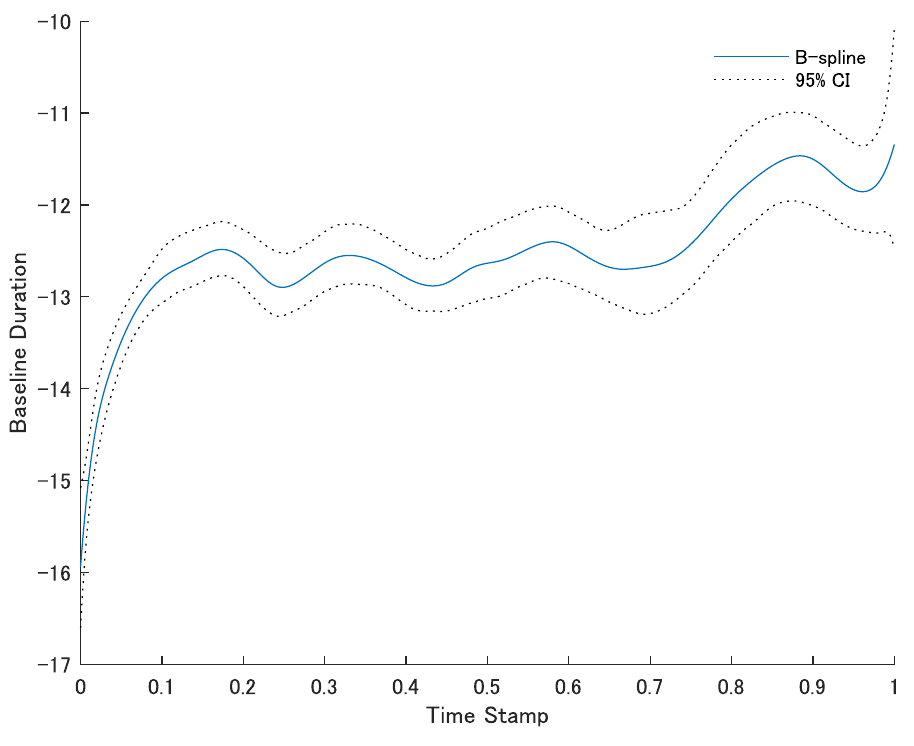
Figure 2. Intraday seasonality of time interval of TMC, Aichi, Japan (23 June